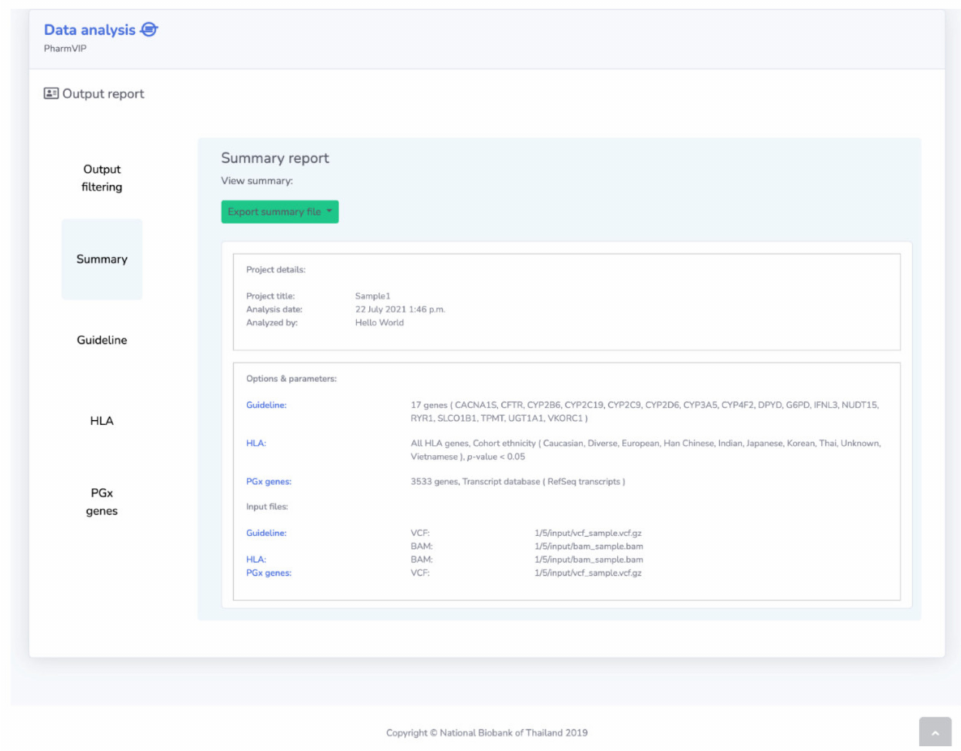
Figure 4. The output report page. The output report page consists of output filtering option(s), a summary report, and full reports of Guideline, HLA, and Pharmacogenes (PGx genes)